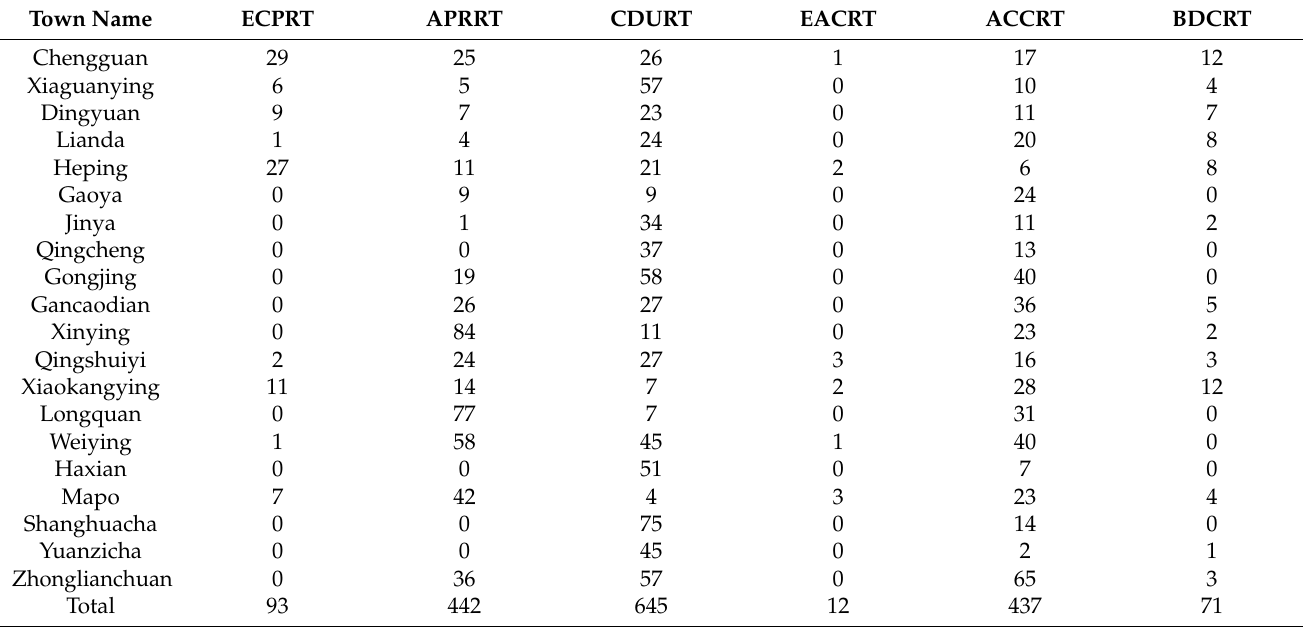
Table 4. Statistical table of the idle residential renovation types in individual